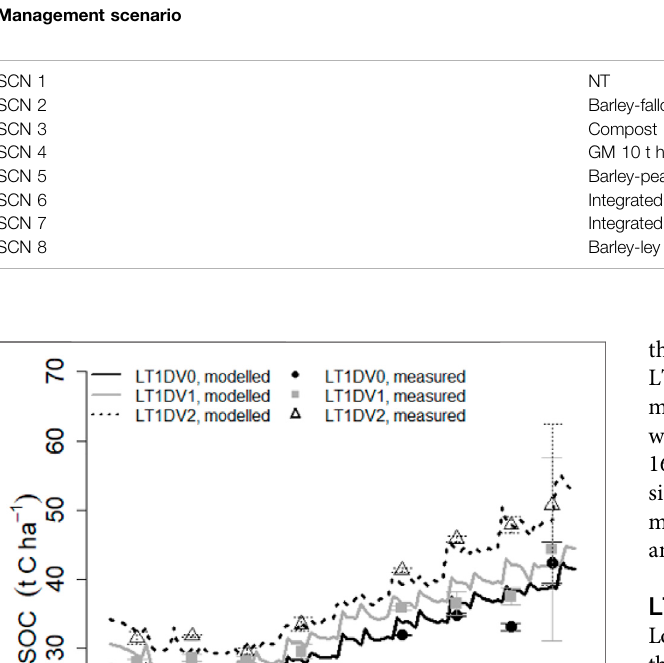
TABLE 2 | Management scenarios considered for the Mediterranean region of Spain (Huesca) for the period 2010 – 2039. Management scenario